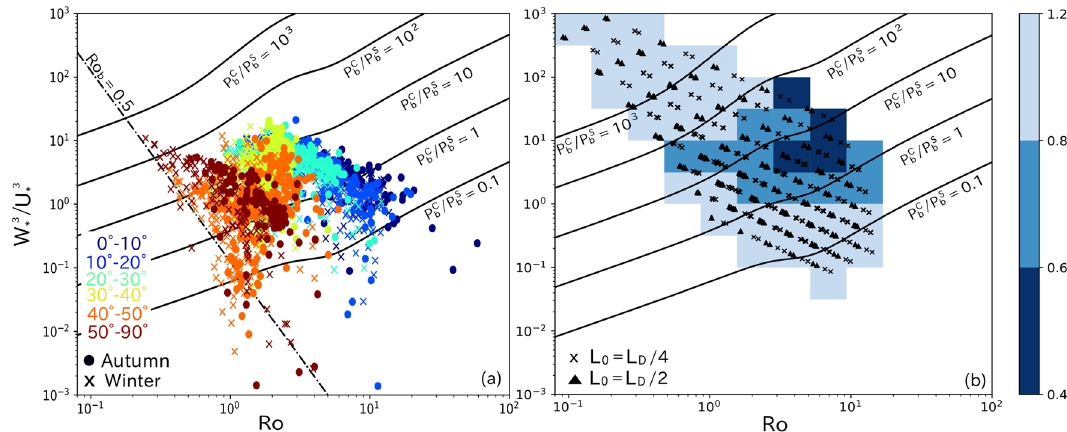
/ U 3 calculated from (a) observed data and (b) LES data. Symbols in (a) ∗ ∗ / P S b b , and dash-dotted line in (a) is contour line of